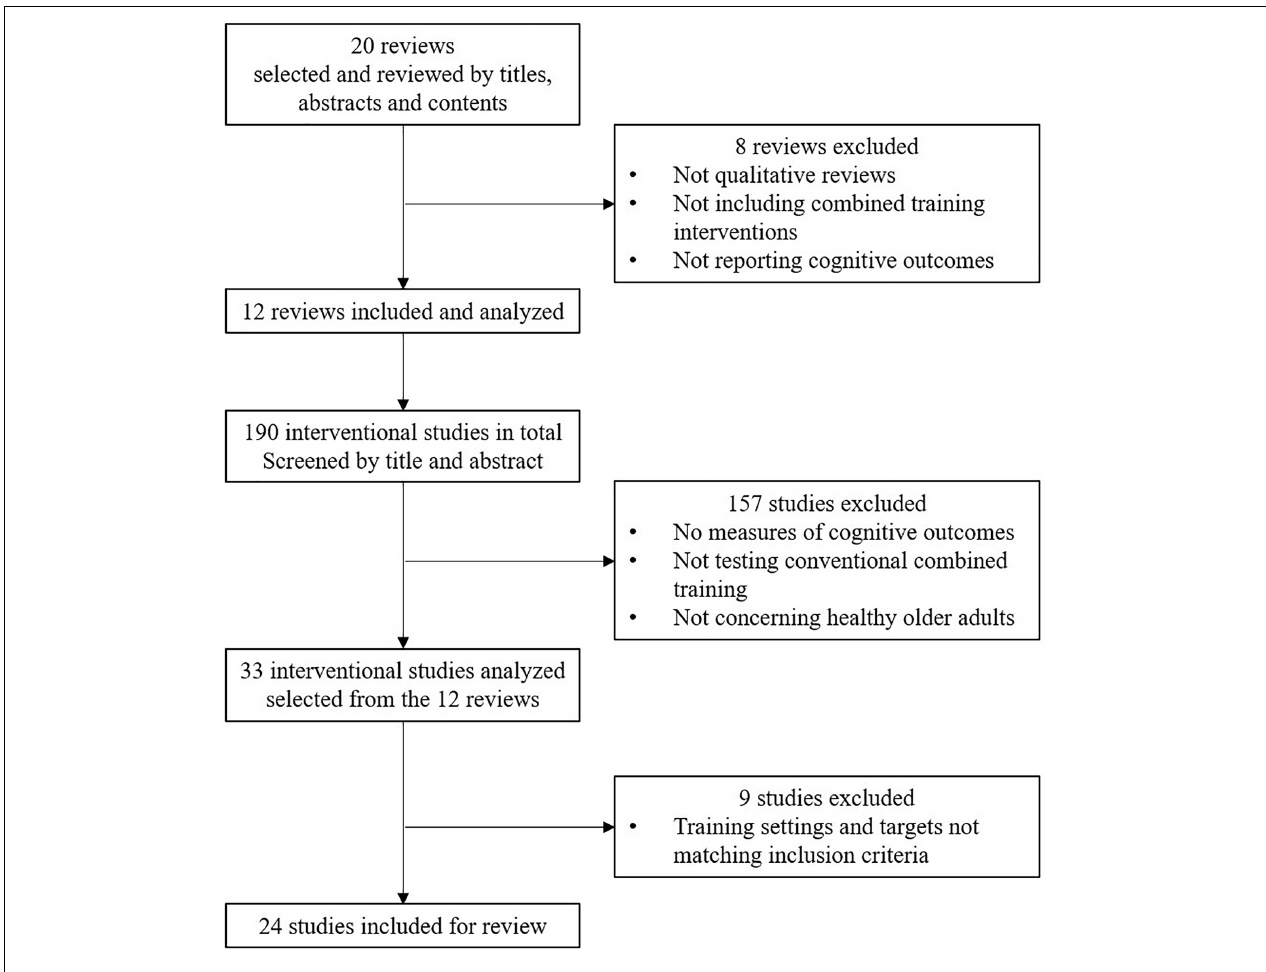
FIGURE 3 | Flow chart of the selection